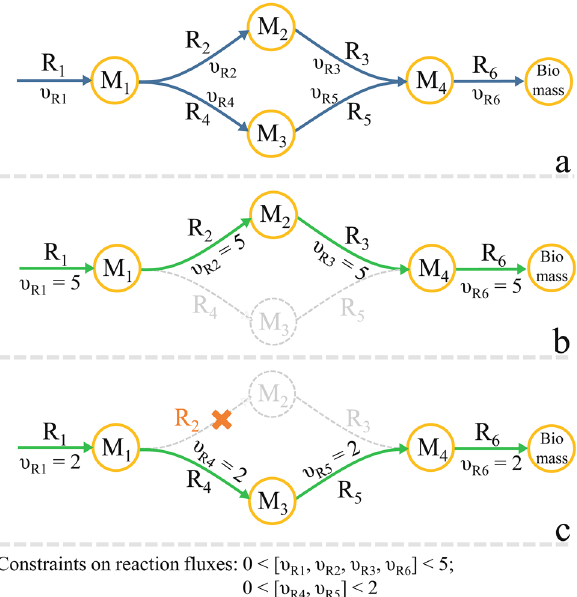
Figure 2. The effect of removing a non-lethal reaction of J nz . ( a ) Toy model; R i denotes the reaction names, and υ Ri represents the flux through R i . ( b ) Flux distribution of the wild-type strain. J nz = (R 1 , R 2 , R 3 , R 6 ). ( c ) Flux distribution of the mutant strain in which R 2 is removed. In order to maximize the flux of R 6 , the R 4 and R 5 reactions gain nonzero fluxes unlike the wild-type strain. Therefore, removing any of the activated reactions R 4 or R 5 will block the flux through R 6 and the biomass objective